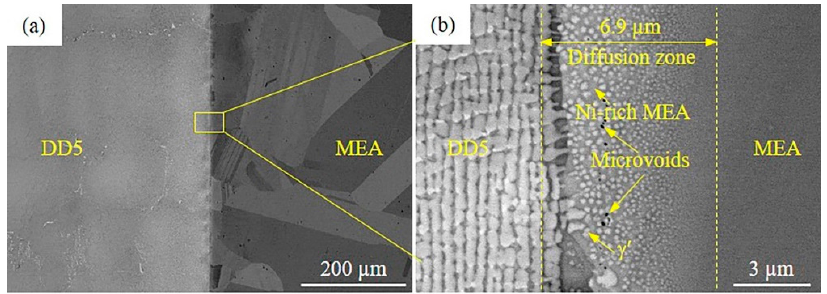
Figure 3. Microstructure of the (CoCrNi) 94 Al 3 Ti 3 MEA/DD5 single-crystal superalloy joint diffusion-bonded at 1110 °C for 1 h: ( a ) interfacial microstructure and ( b ) corresponding magnified photograph.